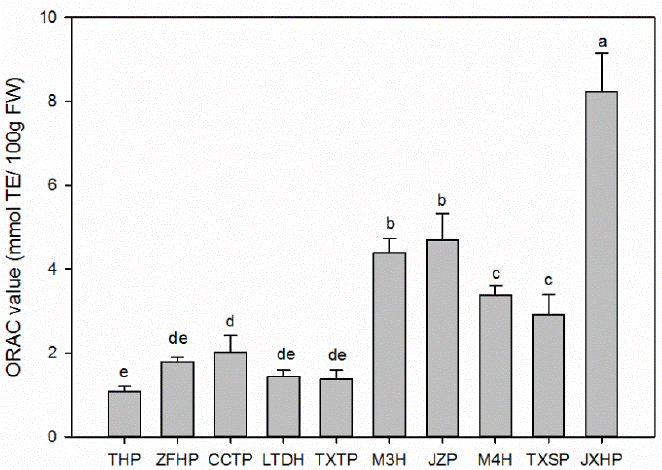
Figure 4. Total antioxidant activities of the five sweet and five sour wampee varieties obtained by the ORAC assay. Bars with no letters in common are significantly different ( p < 0.05).